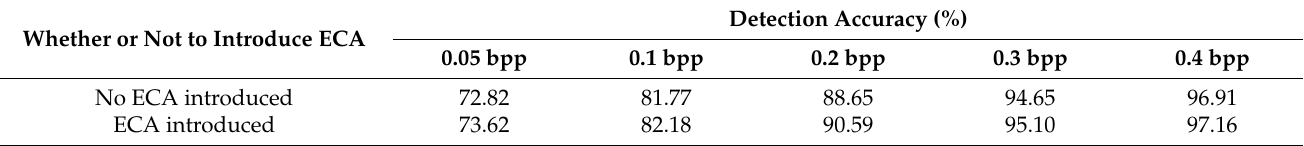
Table 2. Effect of the attention mechanism on model accuracy when using the S-UNIWARD algorithm.